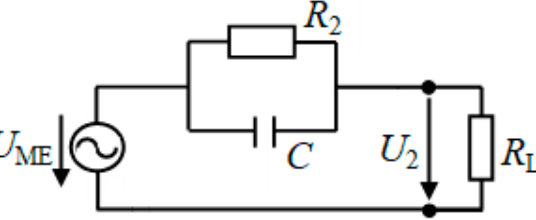
Figure 6. Dependences of ( a ) the voltage transformation ratio K and the output power P 2 on the load resistance R L and ( b ) the resonance frequency f 0 and the quality factor Q on the load resistance R L at H = 6.37 kA / m. The dashed lines in ( a ) are the calculated dependences. Solid lines are drawn to guide the eye. R m is the load resistance for the maximum output power.